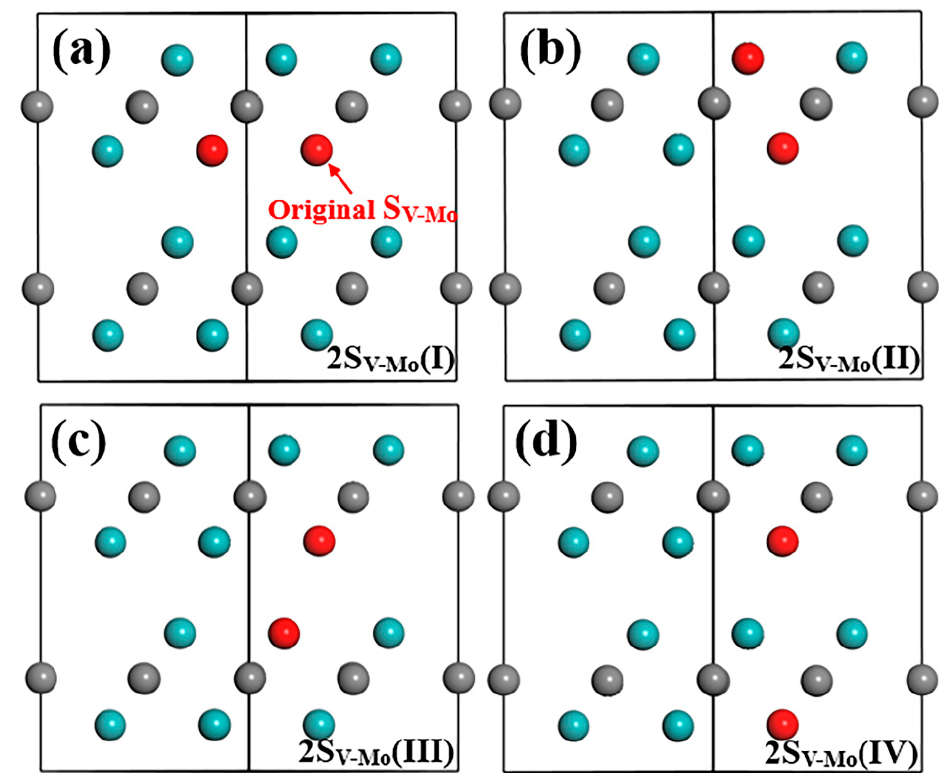
Figure 7. Structure model after optimization in (1120) plane of Mo 2 C supercell with two S V-Mo defects: ( a ) original S V-Mo + S V-Mo in Mo-2 layer (same layer), ( b ) original S V-Mo + S V-Mo in Mo-1 layer (different layer in Layer1), ( c ) original S V-Mo + S V-Mo in Mo-3 layer (different layer in Layer2) and ( d ) original S V-Mo + S V-Mo in Mo-4 layer (different layer in Layer2). Cyan and grey balls represent Mo and C atom, red ball represents V atom. Table 5. Calculated formation energy and binding energy of Mo 2 C supercell with different S V-Mo combinations (eV). Formation Energy Supercell Binding Energy Point